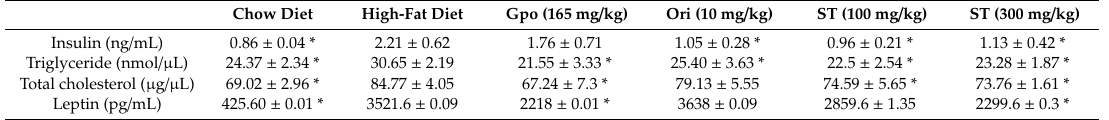
Table 1. E ff ects of Sargassum thunbergii on serum levels of insulin, triglyceride, total cholesterol, and leptin.